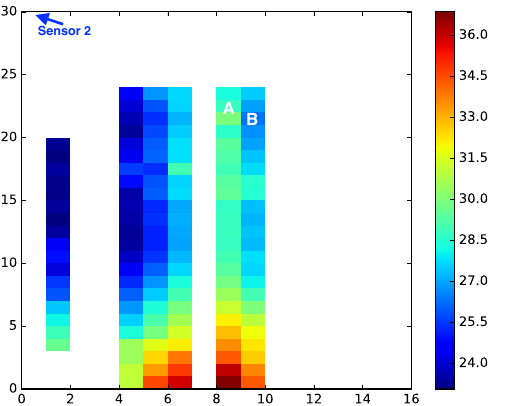
Figure 7. A heat map of arrival time to sensor 2 (located at the upper left corner) from a cross section of the FDTD mesh for KE20. The two axes are given in FDTD indices. Note that FDTD cell A is closer to sensor 2 than cell B, but the travel time from cell A is longer (green) than from cell B